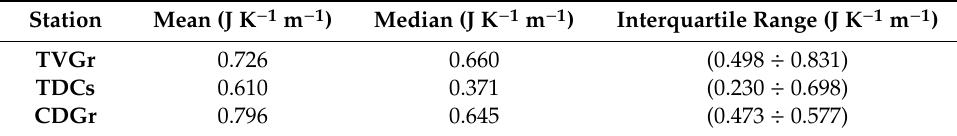
Table 4. Soil Thermal Conductivity for the non-urban stations. Value for the soil layer between depths 0 and 5 cm of depth.